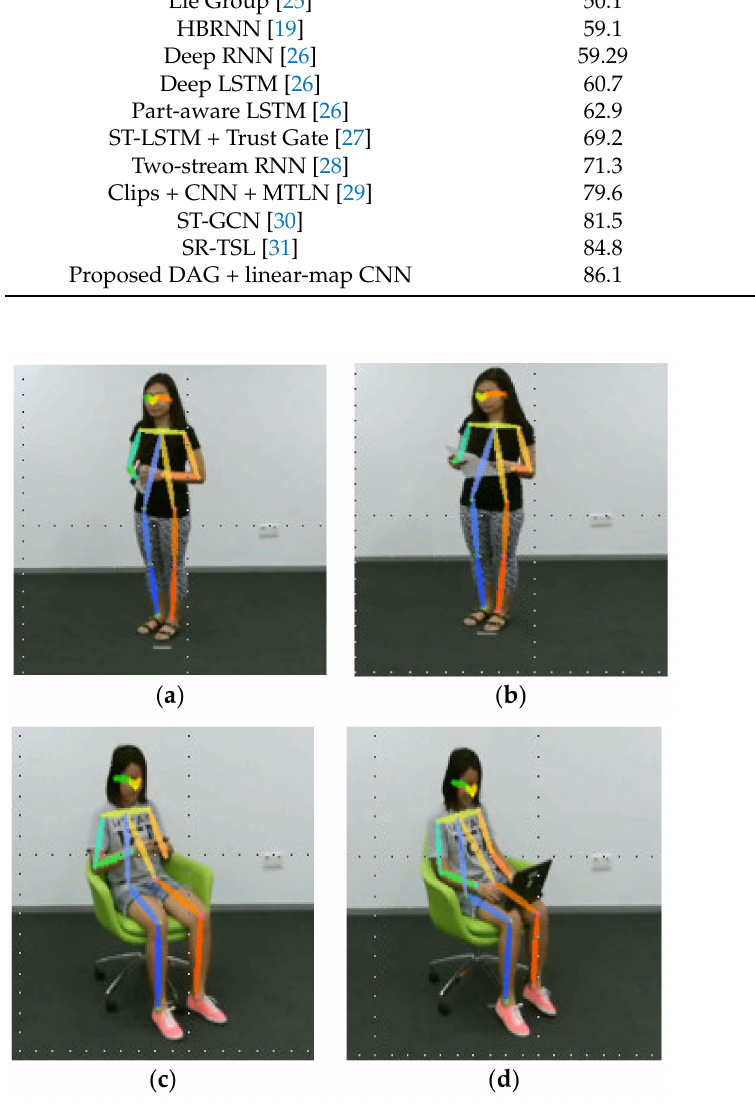
Figure 5. ( a ) the posture of reading, ( b ) the posture of writing, ( c ) the posture of making a phone call, ( d ) the posture of using the